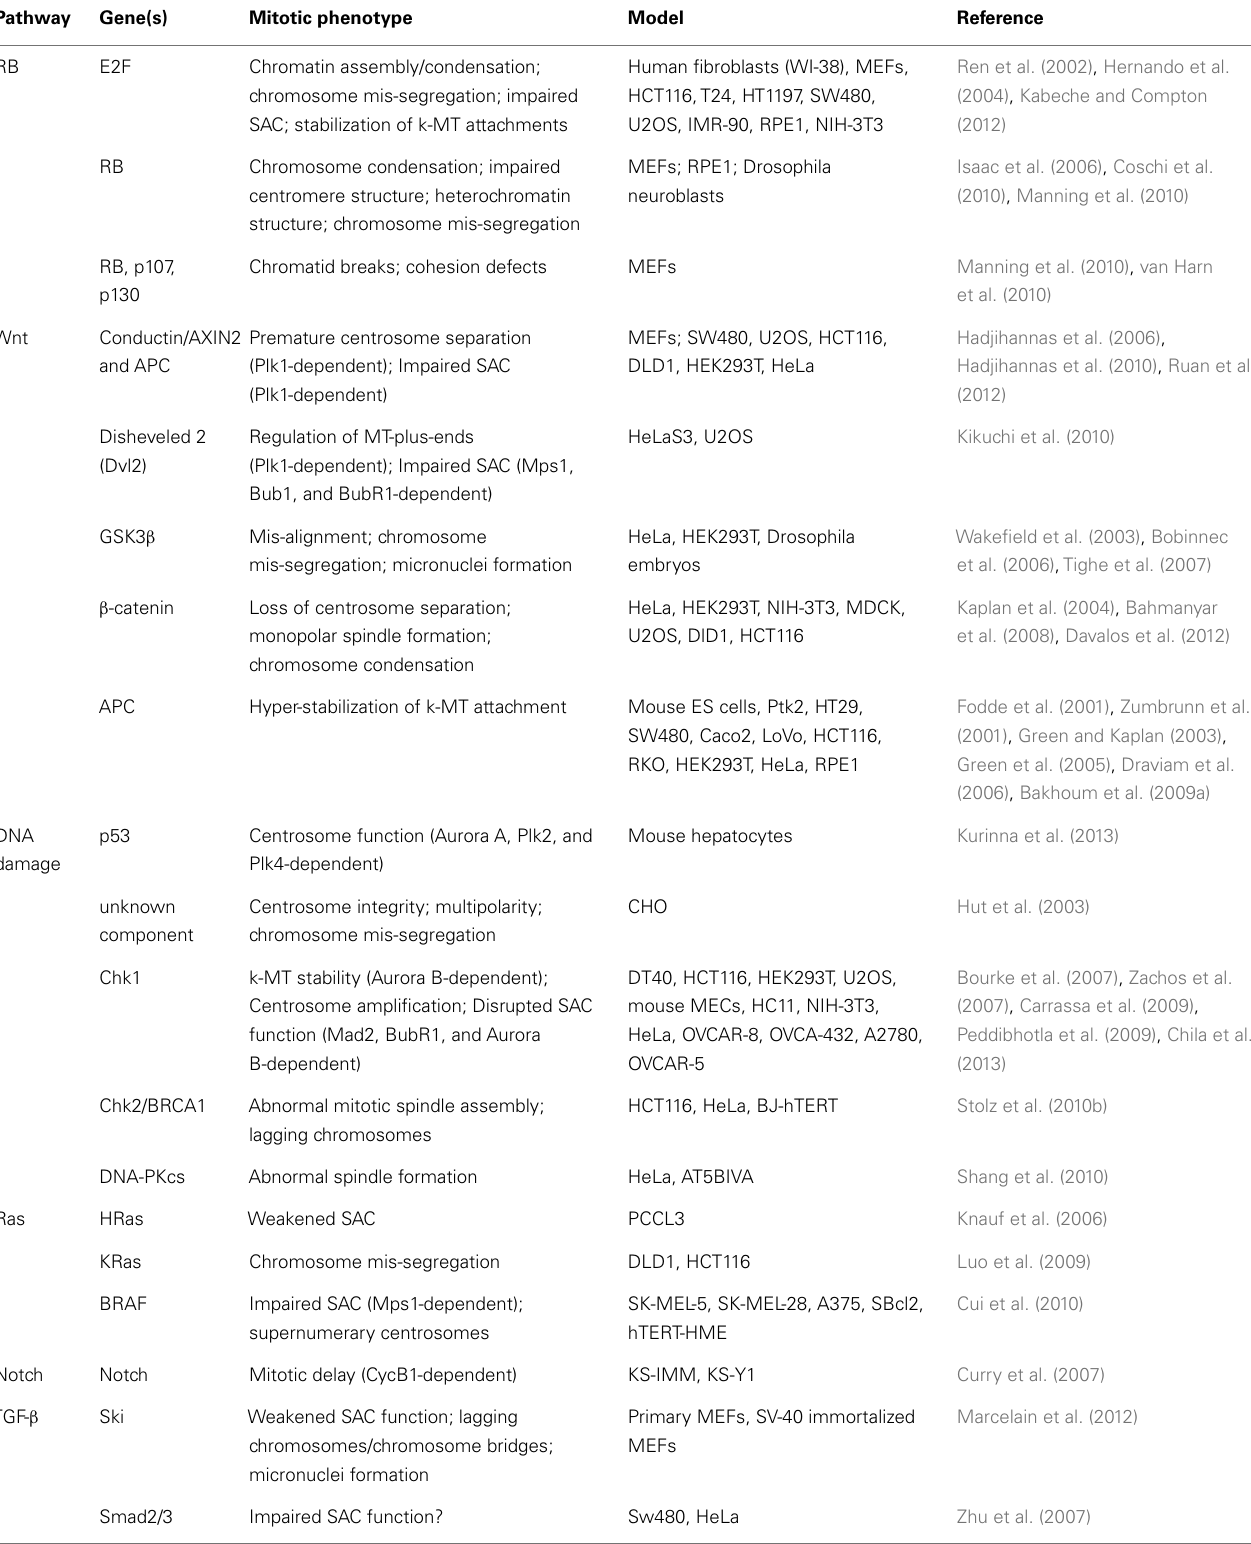
Table 1 |Table summarizing the CIN-causing mitotic phenotypes observed in different cell types and/or models upon de-regulated oncogenic